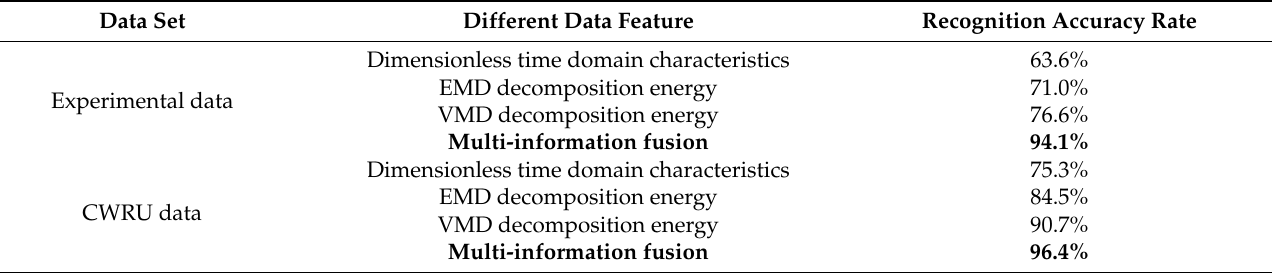
Table 5. The average accuracy of recognition using different feature